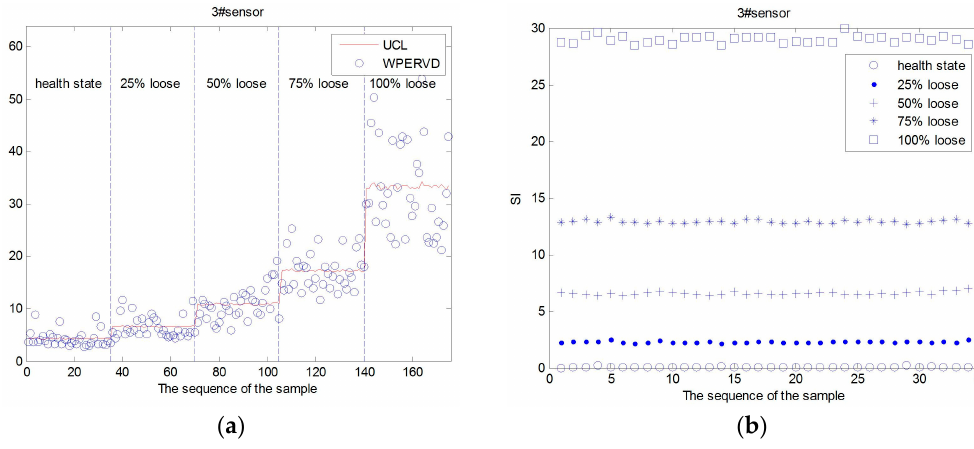
Figure 8. The UCL , WPERVD and SI distribution of sensor #2. ( a ) The UCL and WPERVD distribution of sensor #2; and ( b ) the SI distribution of sensor #2.